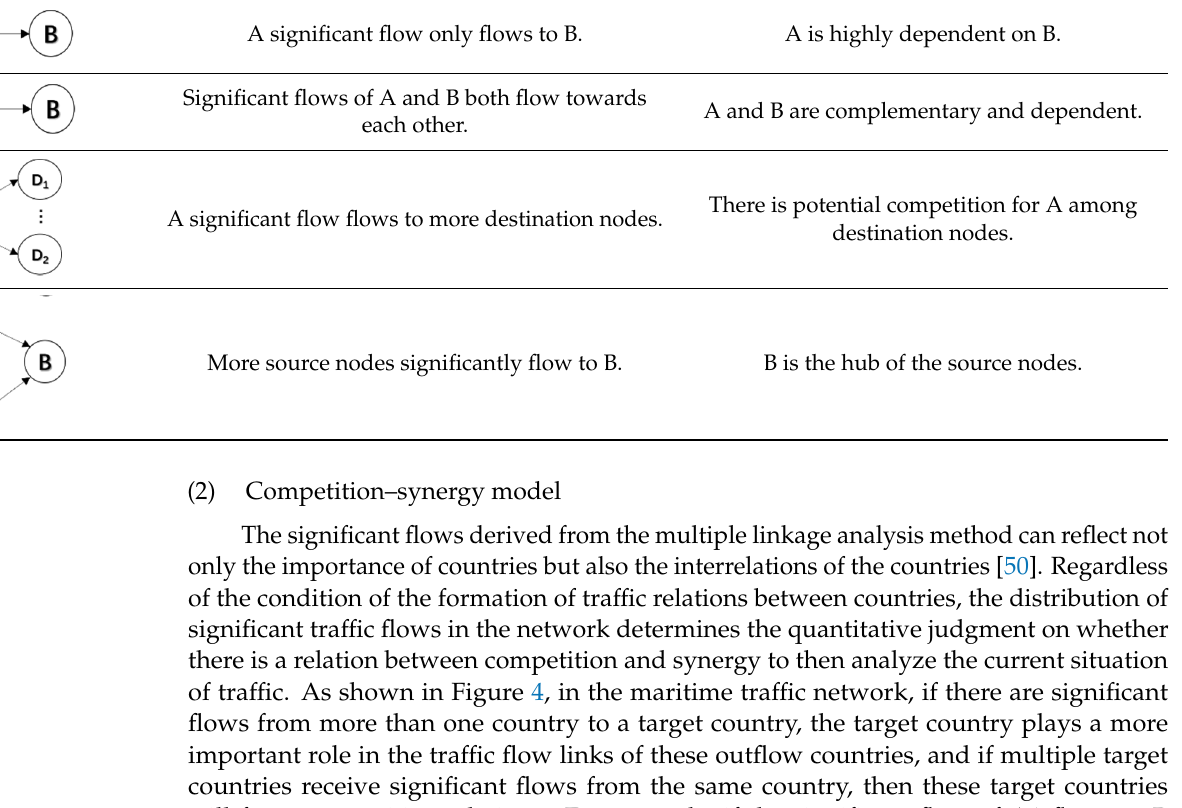
Figure 4. Competition–synergy model based on multiple linkage theory. Source: Adapted from Li et al. [50]. Table 1. Significant flow movement pattern and its influence on network relations.